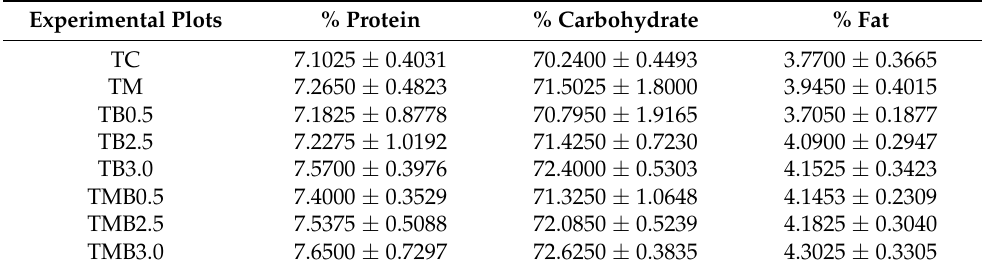
Table 4. Percentage of protein, carbohydrate, and fat content in maize seeds in different experimen- tal plots.